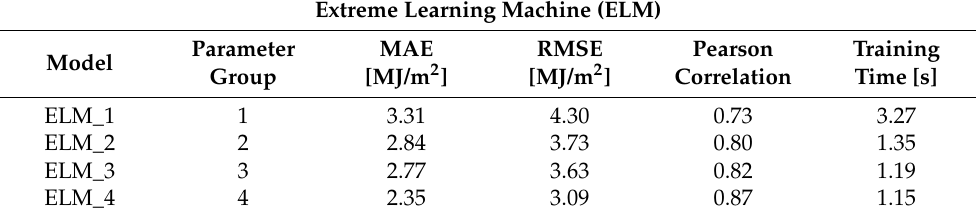
Table 6. ELM forecasting results considering the sine function as the activation function: size 50 of the first block to be processed, size 50 of each chunk to be processed at each step, and 100 neurons at the hidden